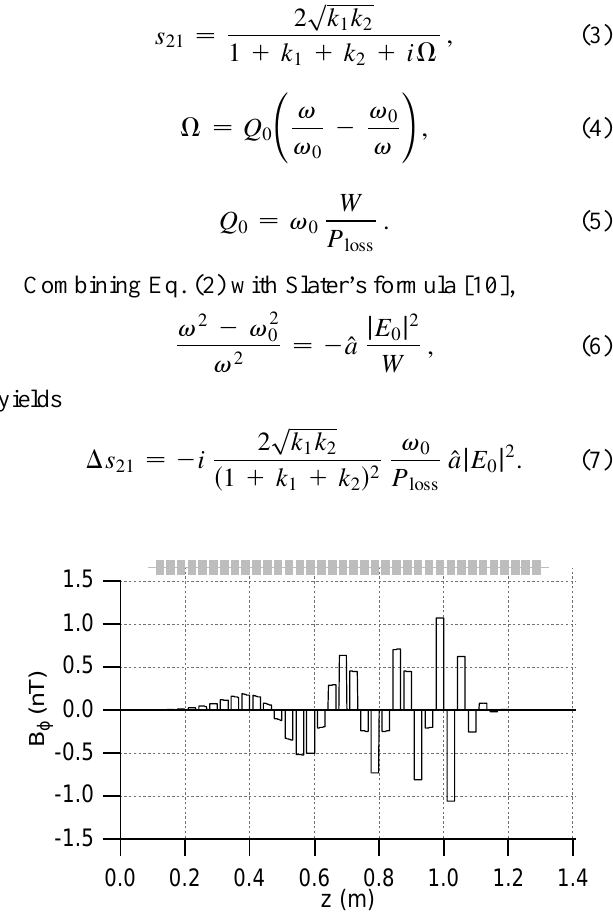
FIG. 3. Field distribution of another trapped mode from the first dipole passband (cid:115) (cid:102) (cid:48) (cid:173) (cid:52)(cid:50)(cid:54)(cid:51)(cid:46)(cid:50) MHz (cid:100)